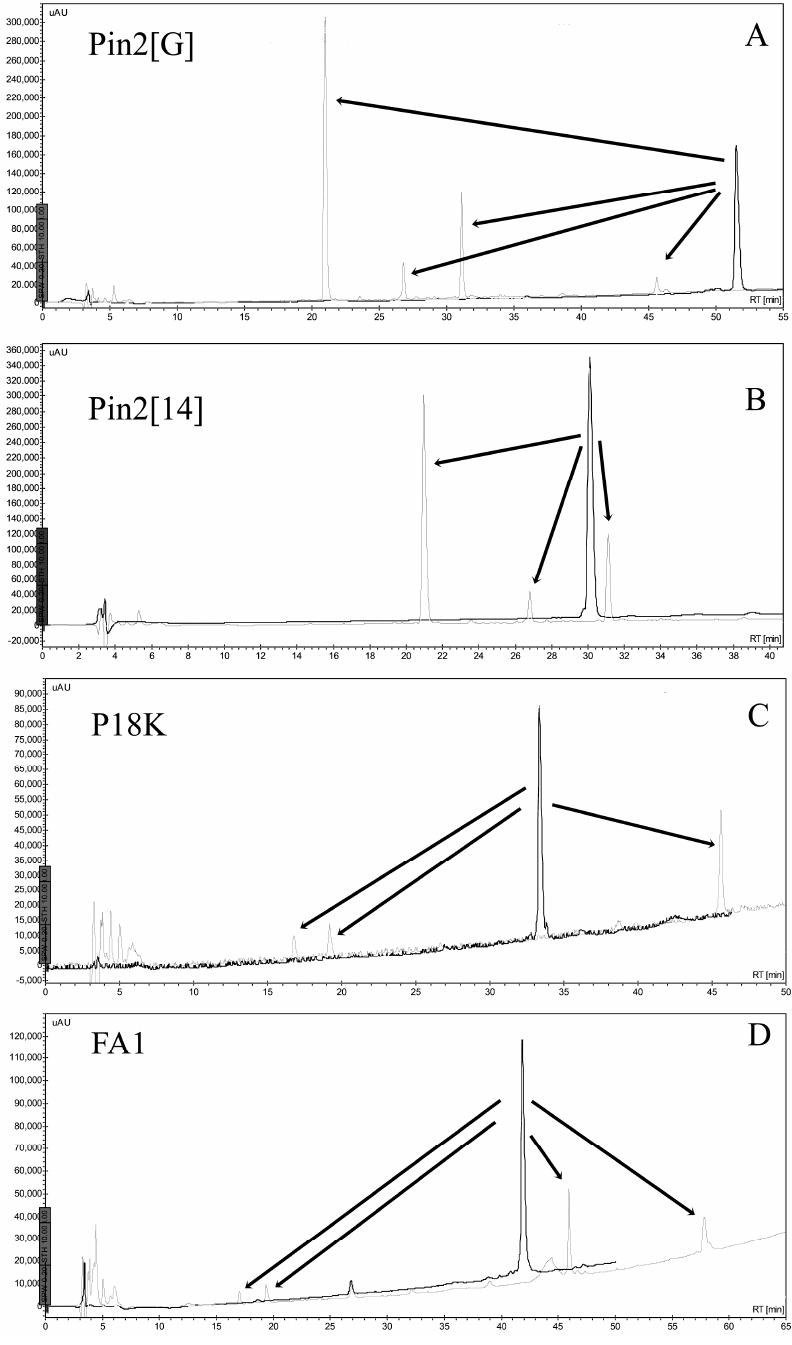
Figure 11. Stability of FA1 and Pin2[G] in the presence of elastase. The peptides were diluted in buffer and incubated at 37 °C for 12 h and then directly separated using reverse phase HPLC. ( A ) Pin2[G]; ( B ) Pin2[14]; ( C ) P18K; and ( D )